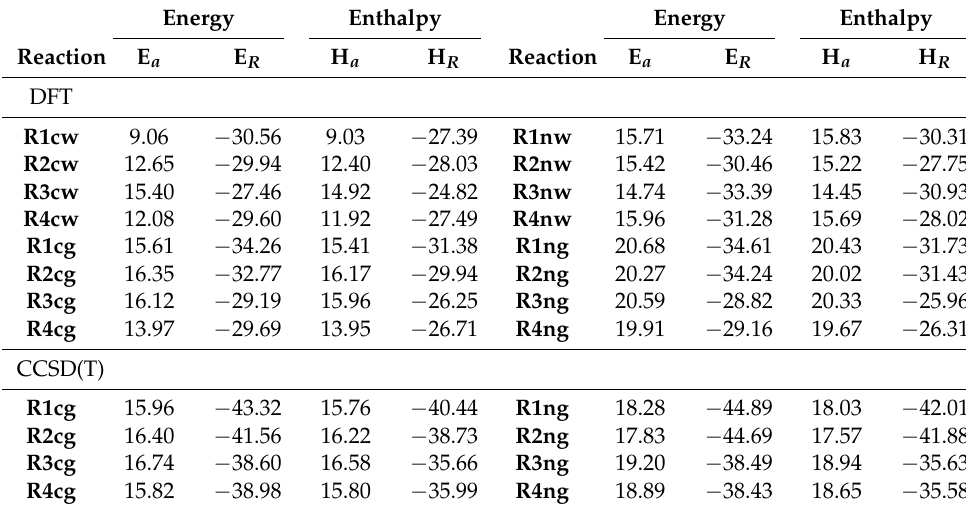
Figure 2. Energy profiles for: ( a ) catalyzed reactions in water solution R1cw , R2cw , R3cw , and R4cw ; ( b ) non-catalyzed reactions in water solution R1nw , R2nw , R3nw , and R4nw ; ( c ) catalyzed reactions in the gas phase R1cg , R2cg , R3cg , and R4cg ; ( d ) non-catalyzed reactions in the gas phase R1ng , R2ng , R3ng , and R4ng . B3LYP/6-311+G(2d,p)/AMBER level of theory for aqueous solution and B3LYP/6-311+G(2d,p) level of theory for gas phase calculations. Table 1. Activation energy E a , reaction energy E R , activation enthalpy H a , and reaction enthalpy H R of the reactions investigated in our study a . The B3LYP/6-311+G(2d,p)/AMBER level of theory for water solution. Gas phase: B3LYP/6-311+G(2d,p) level of theory, and DLPNO-CCSD(T)/def2-TZVP level of theory with thermochemical corrections from the DFT